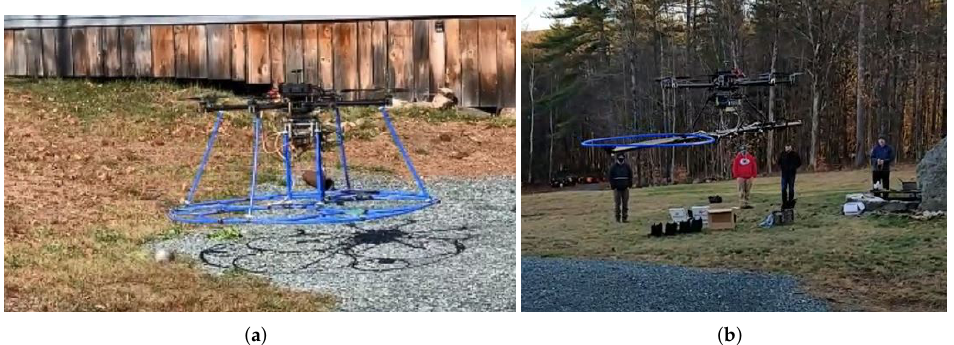
Figure 1. Previous UAS-mounted remote sensing systems. ( a ) UXO detection system. ( b ) Soil conductivity detection